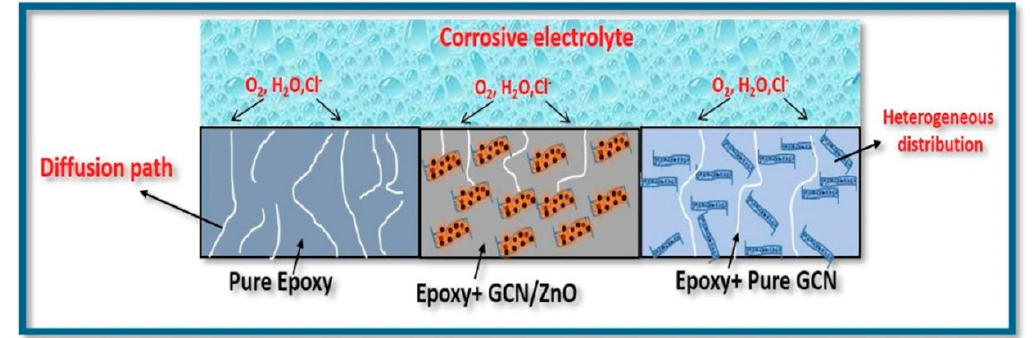
Figure 9. Schematic representation of penetration of aggressive species from a corrosive electrolyte (3.5% NaCl solution) into epoxy coatings with and without GCN / ZnO nanoparticles (GCN: graphitic carbon nitride). Reprinted with permission [70].